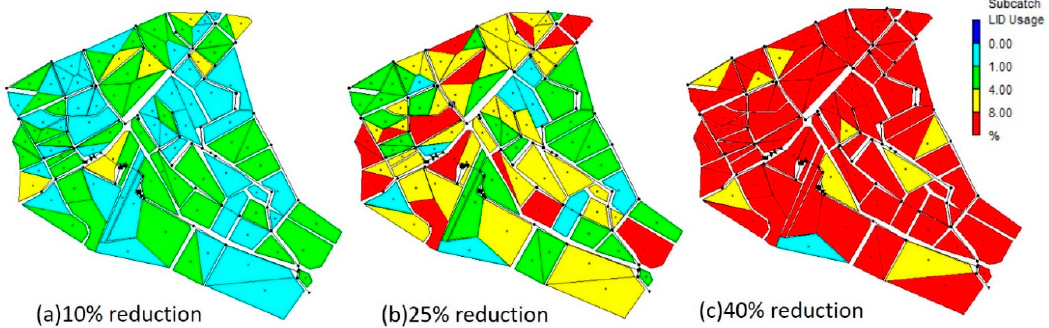
Figure 5. Percentage of LID area identified for each sub-catchment with a 2-year return period for cases: ( a ) 10% reduction; ( b ) 25% reduction; ( c ) 40% reduction